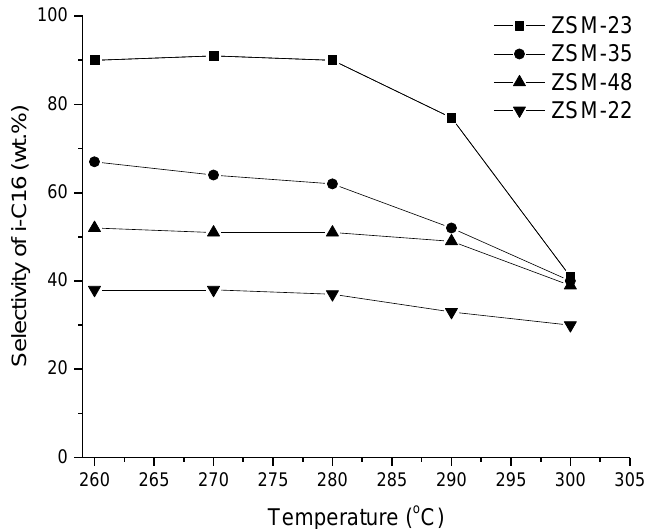
Figure 7. The selectivity to isohexadecane as a function of reaction temperature under 40 bar over different Pt-ZSM catalysts [19]. Reproduced with permission from Zhang et al., Ind. Eng. Chem. Res. ; published by American Chemical Society, 2013 .